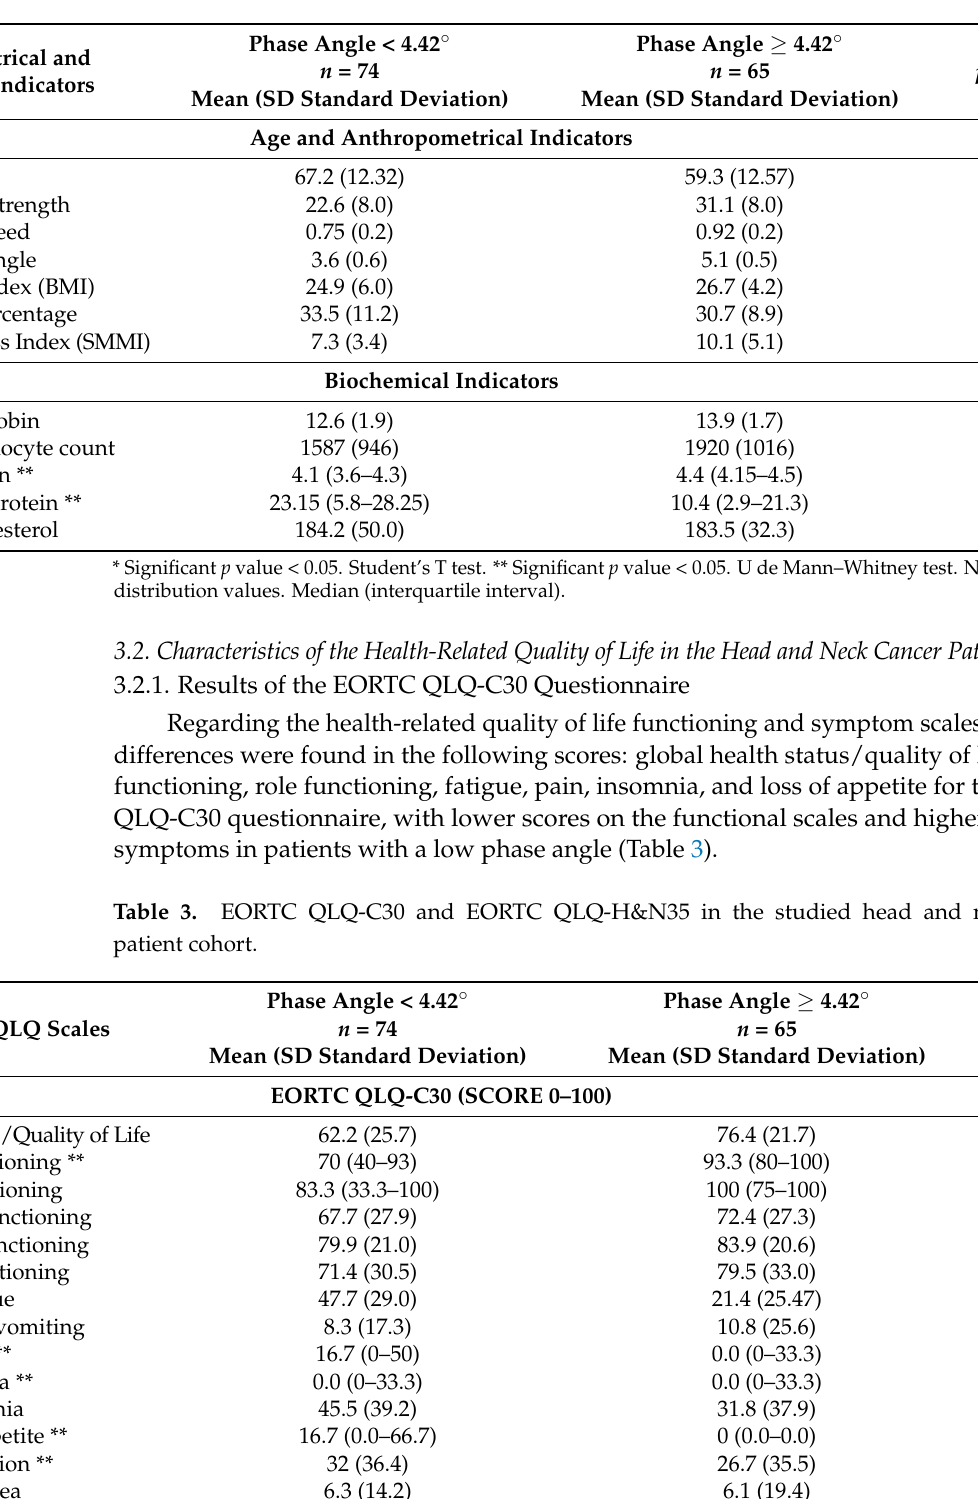
Table 2. Characteristic of the anthropometric and biochemical parameters in the cohort of head and neck cancer patients studied.